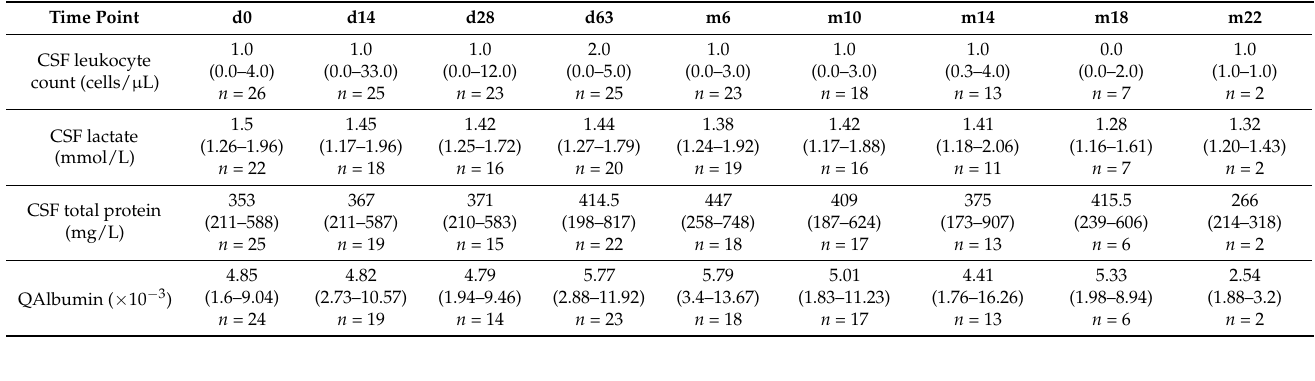
Table 2. Overview of CSF routine parameters at the nusinersen application time points (d0 to m22). Values for time point m22 were not further analyzed. Values are presented as the median and range. n describes the number of analyzed samples. CSF: cerebrospinal fluid; d: day; m: month; QAlbumin: CSF/serum albumin quotient.